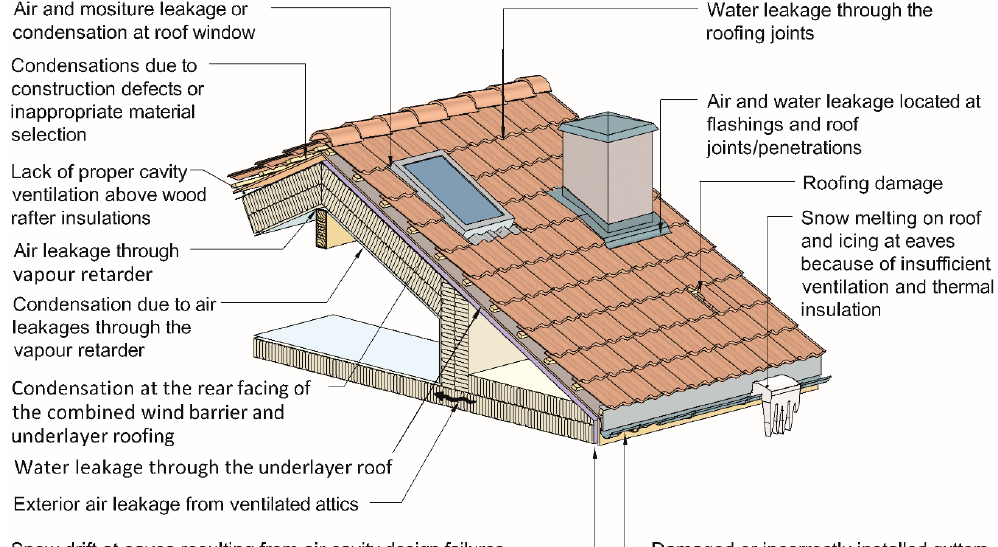
Figure 7. Typical defects in thermally insulated pitched wooden roofs according to findings from SINTEF’s building defect archive.